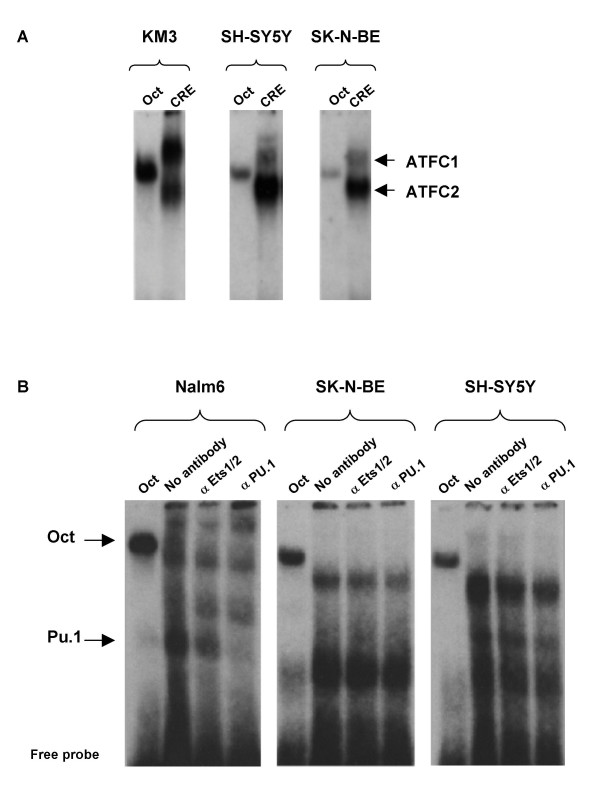
Neuroblastoma and pre-B lymphoma differs in expression of CRE and Pu.1 site binding proteins. Panel (A) display EMSA analysis of nuclear extracts from pre-B (KM3) or neuroblastoma cells (SH-SY5Y and SK-N-BE(2)c) incubated with a consensus cAMP responsive element (CRE). The two major complexes are denoted ATFC1 and ATFC2. Panel (B) show an EMSA analysis using nuclear extracts from either pre-B lymphoma cells (Nalm6) or the neuroblastoma cells SH-SY5Y and SK-N-BE(2)c, incubated with a labelled Pu.1 binding site from the mouse Immunoglobulin l enhancer (lB). Ets1/2 or PU.1 antibody was included in the reactions as indicated. The arrow indicates the complex super-shifted by the anti PU.1 antibody.